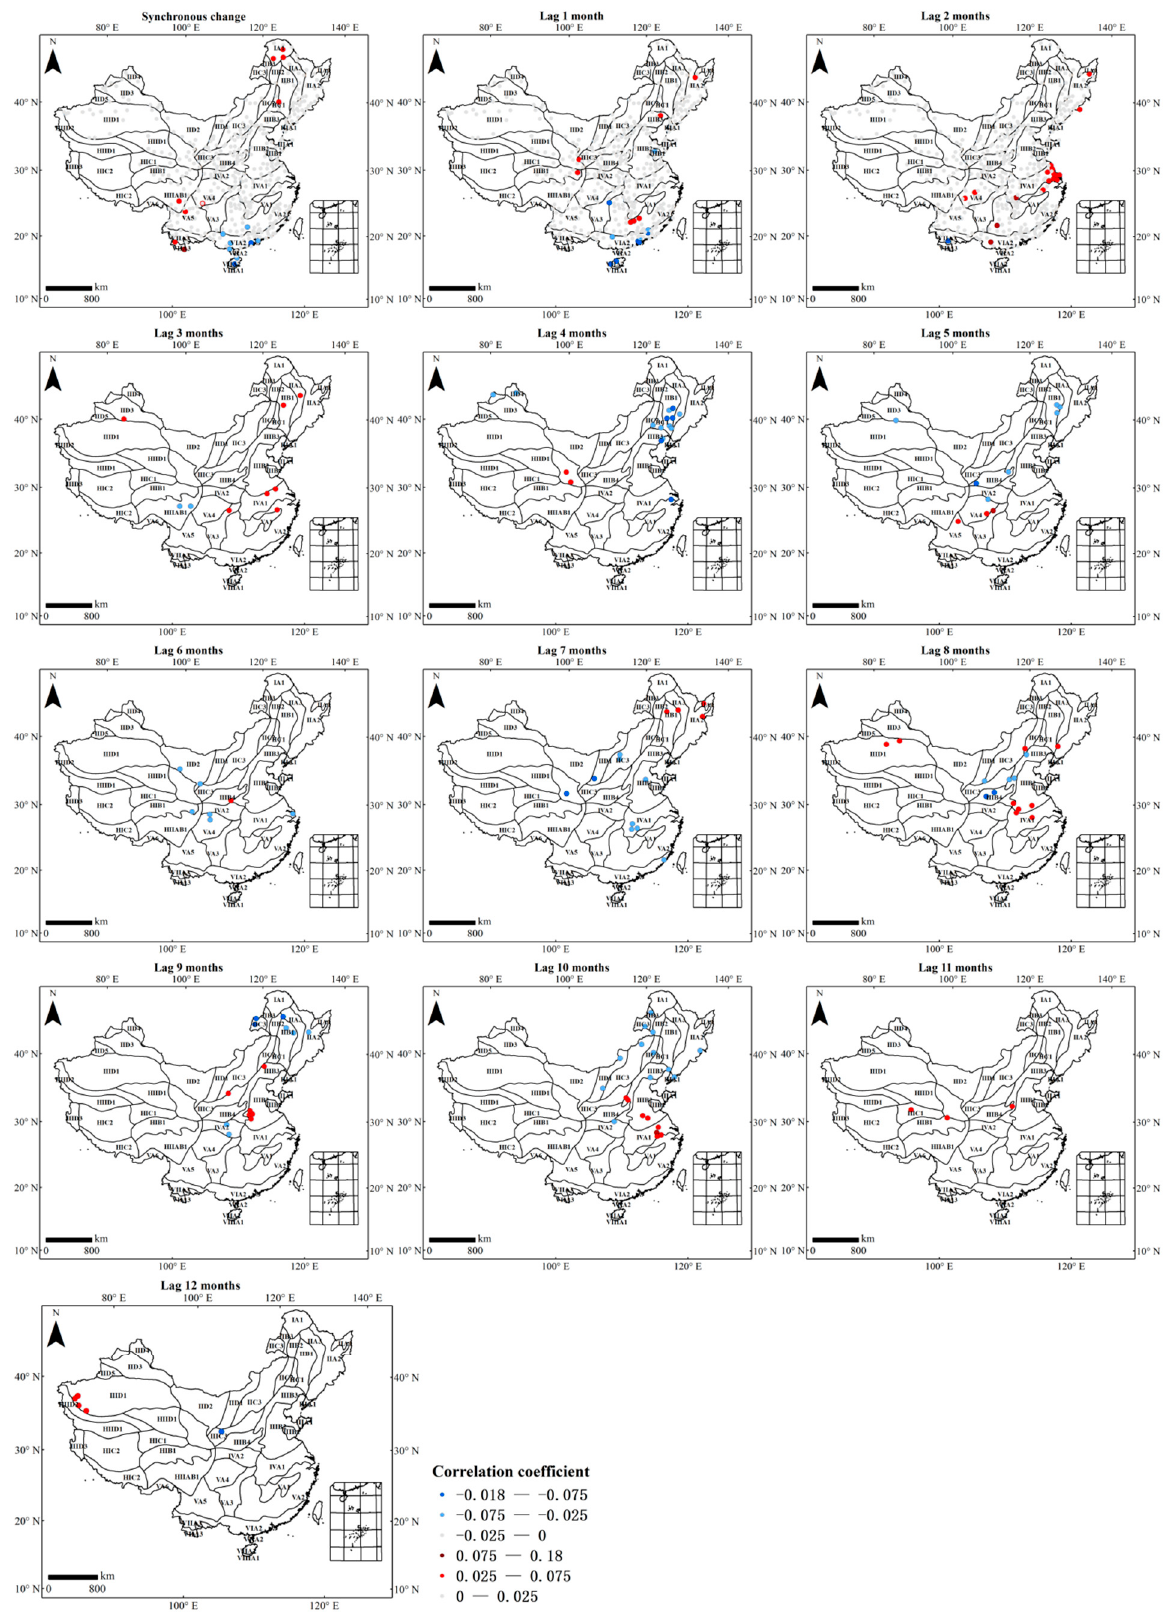
Figure 3. Extent and time lag of drought due to the weakest El Niño event (identified by Niño3.4 index).